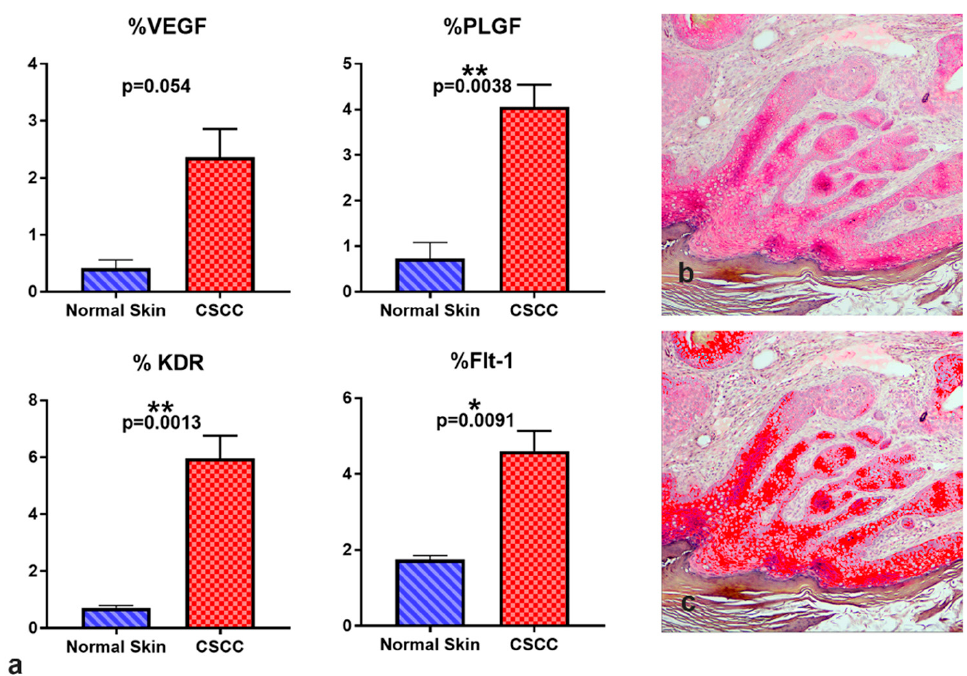
Figure 7. Quantification of angiogenic marker immunoreactivity in NHS and CSCC. ( a ) Using Image J, positive immunoreactive area was estimated as a percentage of total frame area for the indicated angiogenic biomarkers. ( b ) Representative image of pink Flt-1 immunoreactivity in CSCC. ( c ) Pixels flagged in red defined as Flt-1-positive by the image analysis of the same section.